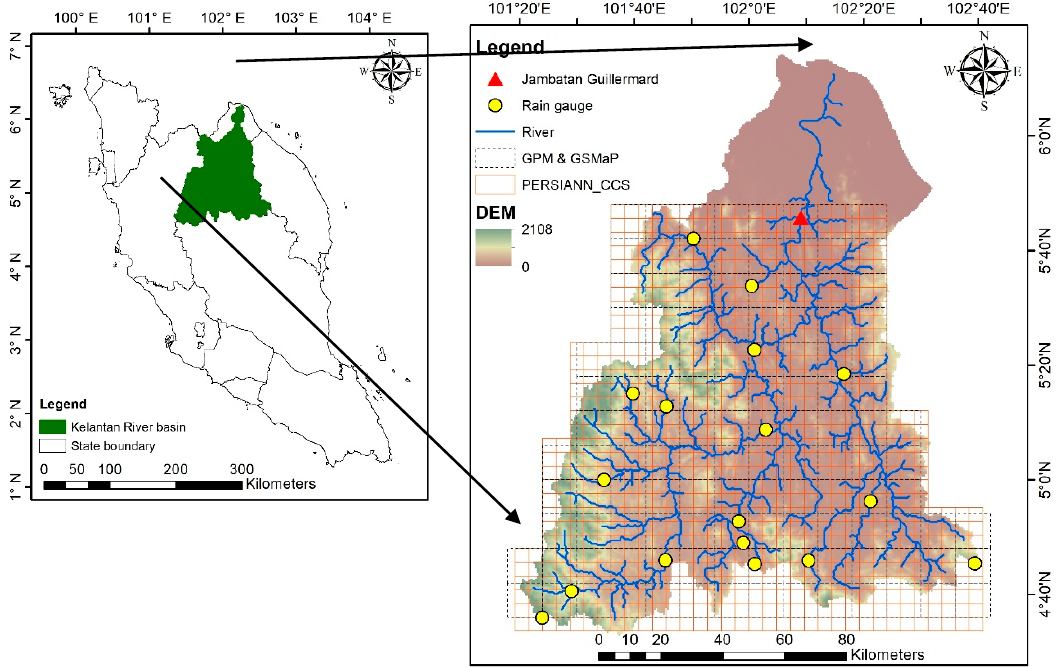
Figure 1. Distribution of rain gauges and Jambatan Guillermard river flow measuring station in Kelantan River basin and the resolution (Global Satellite Mapping of Precipitation (GSMaP) and Global Precipitation Measurement (GPM) with 0.1 ° ; Precipitation Estimation from Remotely Sensed Information using Artificial Neural Networks-Cloud Classification System (PERSIANN-CCS) with 0.04 ° ) and coverage of different satellite rainfall products.